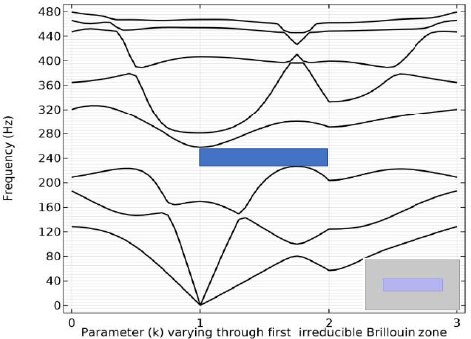
Figure 8. Dispersion relationship of the conventional unit